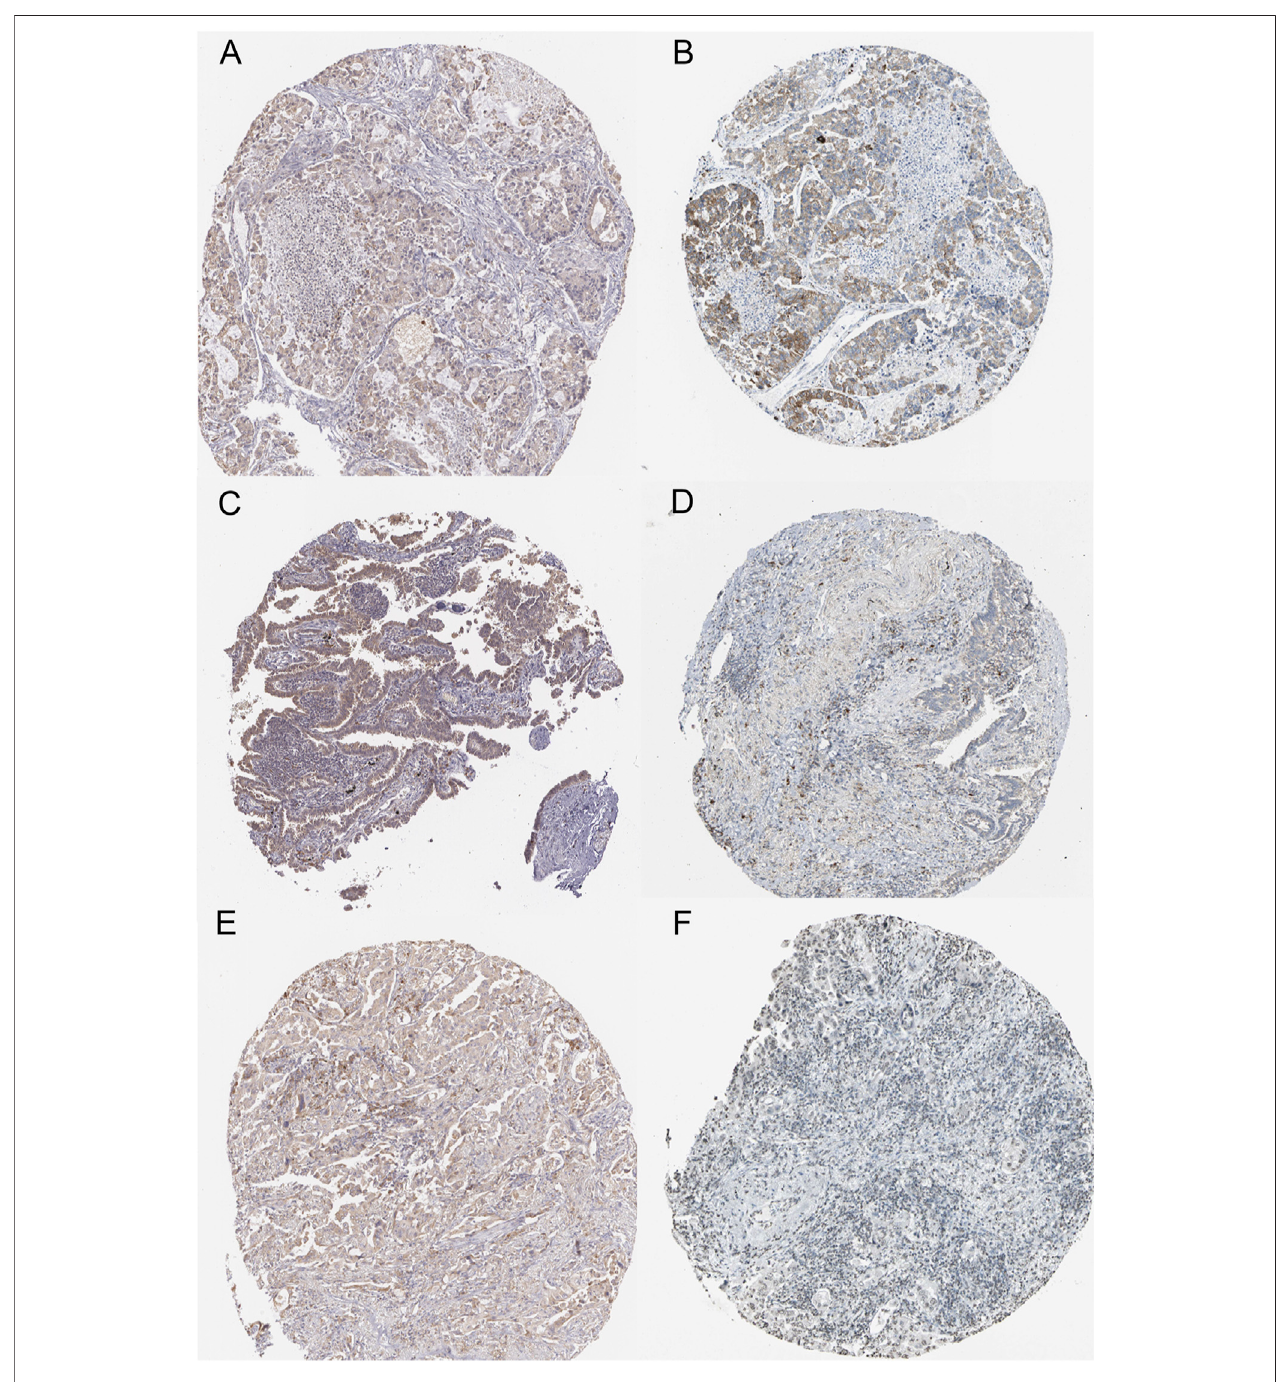
FIGURE 13 | Immunohistochemical staining images of LUAD tumor tissues of CCL17 and speci fi c immune cell marker molecules in the HPA database. (A-B) Immunohistochemical staining images of CCL17 (A) and CD3G (B) in LUAD patient number 2041. (C-D) Immunohistochemical staining images of CCL17 (C) and CD4 (D) in LUAD patient number 2438. (E-F) Immunohistochemical staining images of CCL17 (E) and CD79B (F) in LUAD patient number 2403.